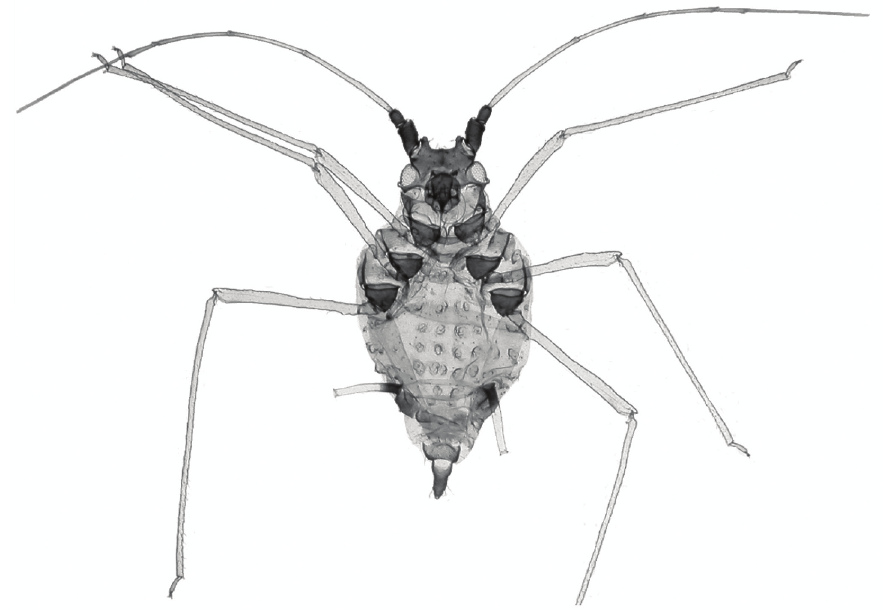
Fig. 32. Idiopterus nephrelepidis Davis, 1909. Aptera (photo roger blackman, from blackman 2010, with license from the royal entomological